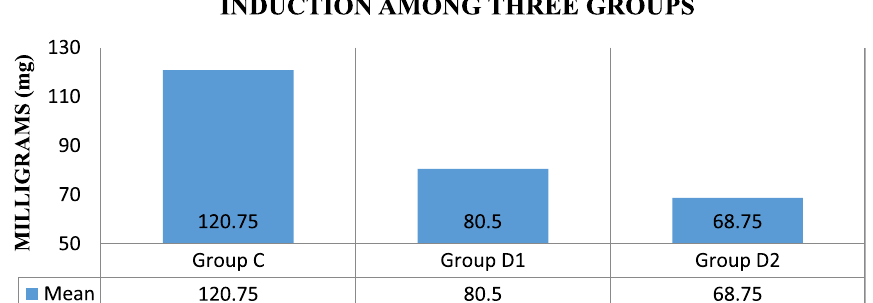
Fig. 8 Comparison of dose of propofol required for induction among three groups